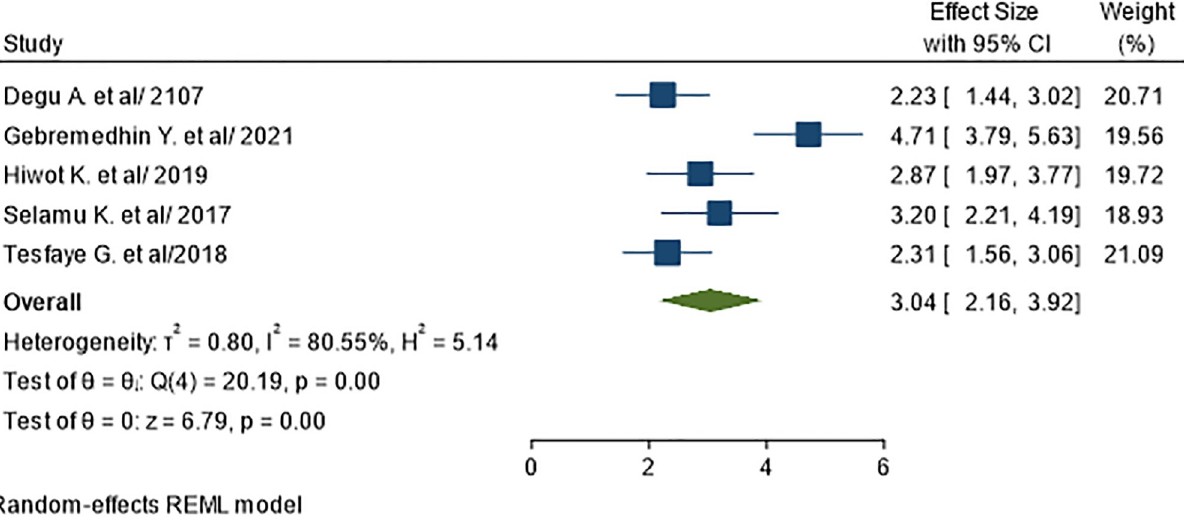
Fig 11. Association between prior UTI history and UTI in diabetic